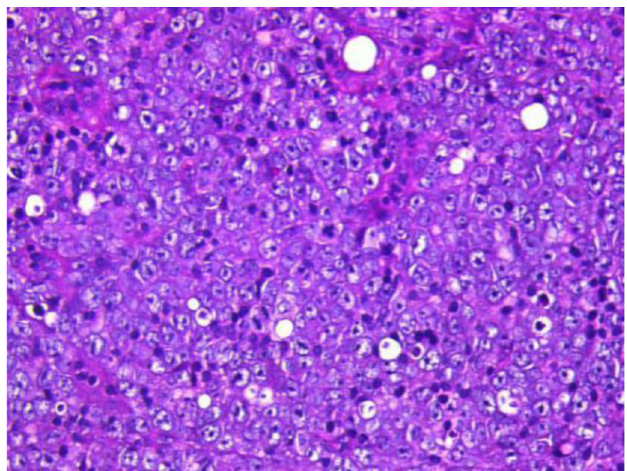
Fig. 3. Proliferation of large lymphoid cells (HES, X400).